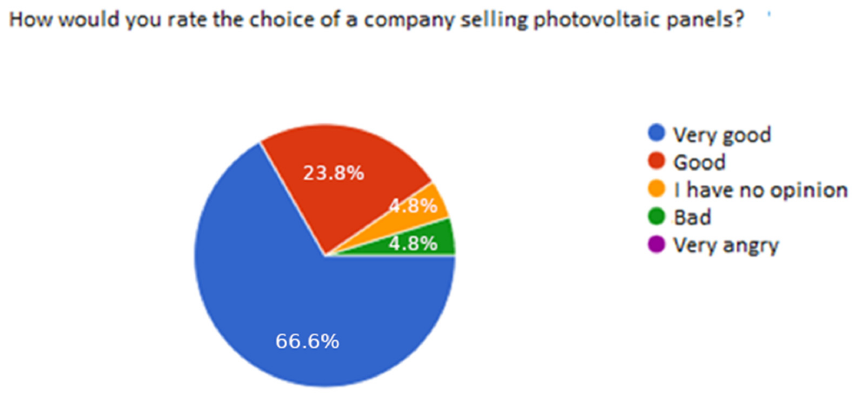
Figure 17. Opinion about the service provider.